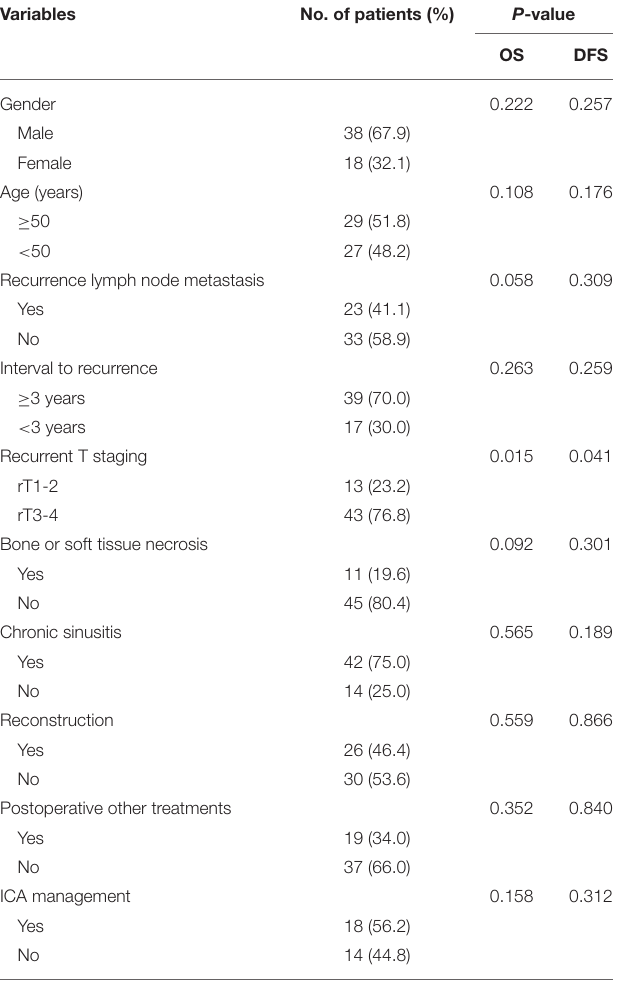
TABLE 2 | Univariate analysis of prognostic factors associated with OS and DFS in patients with RNPC.